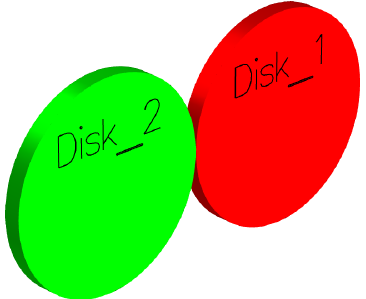
Figure 3: The two disk model. Both discs rotate with same speed in different directions, i.e., per- fect rolling conditions. One disc is loaded in the contact normal direction, the other degrees of freedom are prescribed or locked. The axial width is 10 mm. The simulations are run until steady state conditions